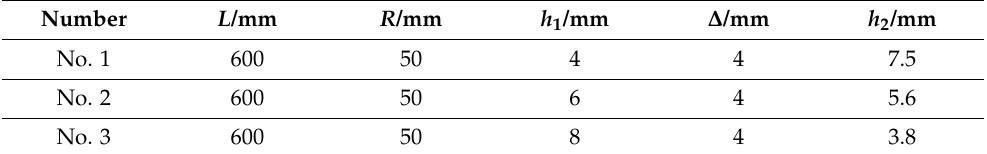
Table 1. Parameters of double-layer steel shells.